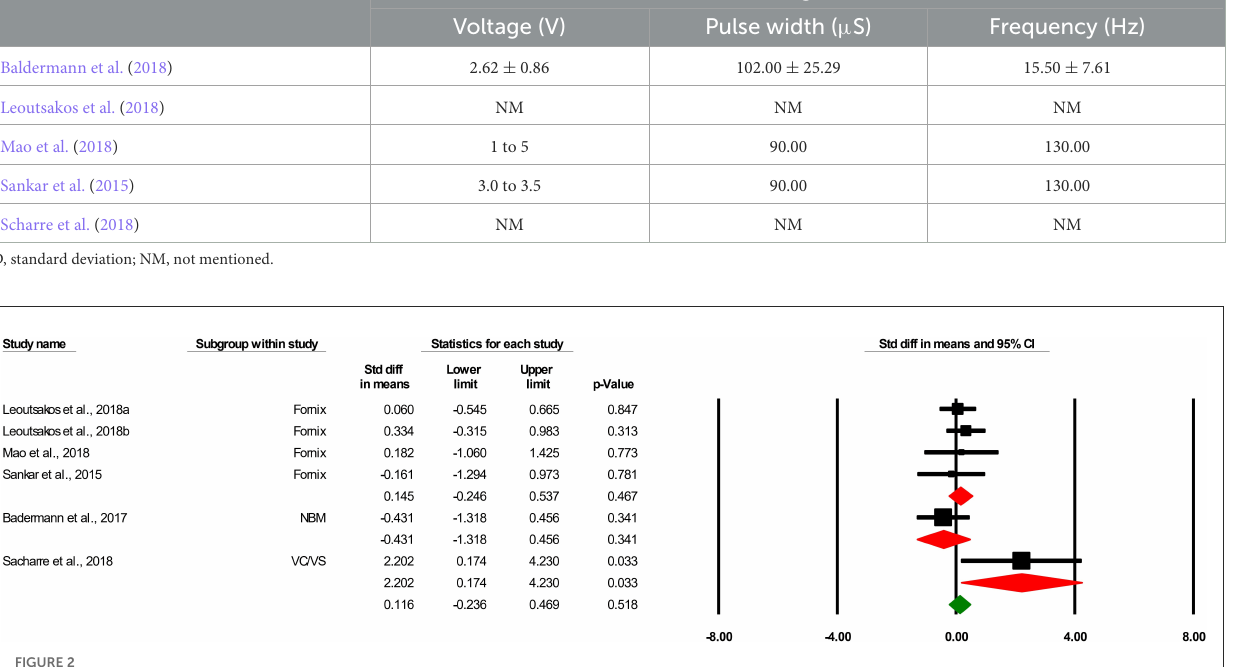
FIGURE2 Forest plot of standardized mean difference (SMD) for the effect of deep brain stimulation on cognitive outcomes in different subgroups (target) in patients with Alzheimer’s disease. The green square shows the overall pooled effect. Red squares show pooled effects in each subgroup. Black squares indicate the SMD in each study. Horizontal lines represent a 95% confidence interval (CI).